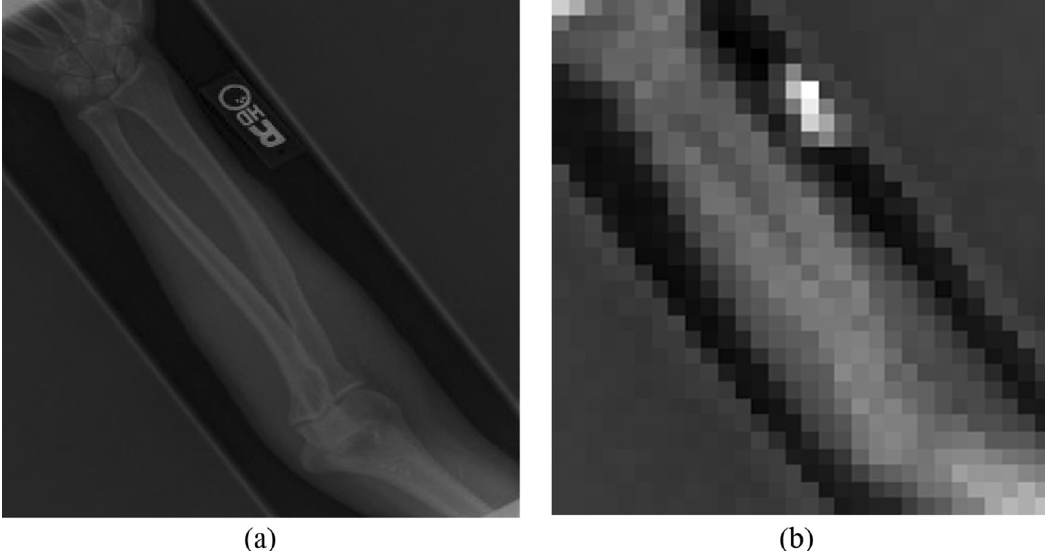
Figure 3. Ensuring privacy of original medical data. Image ( a ) is the original image of the MURA bone X-ray scans. Image ( b ) shows the highly distorted image after passing through one hidden layer at the hospitals.